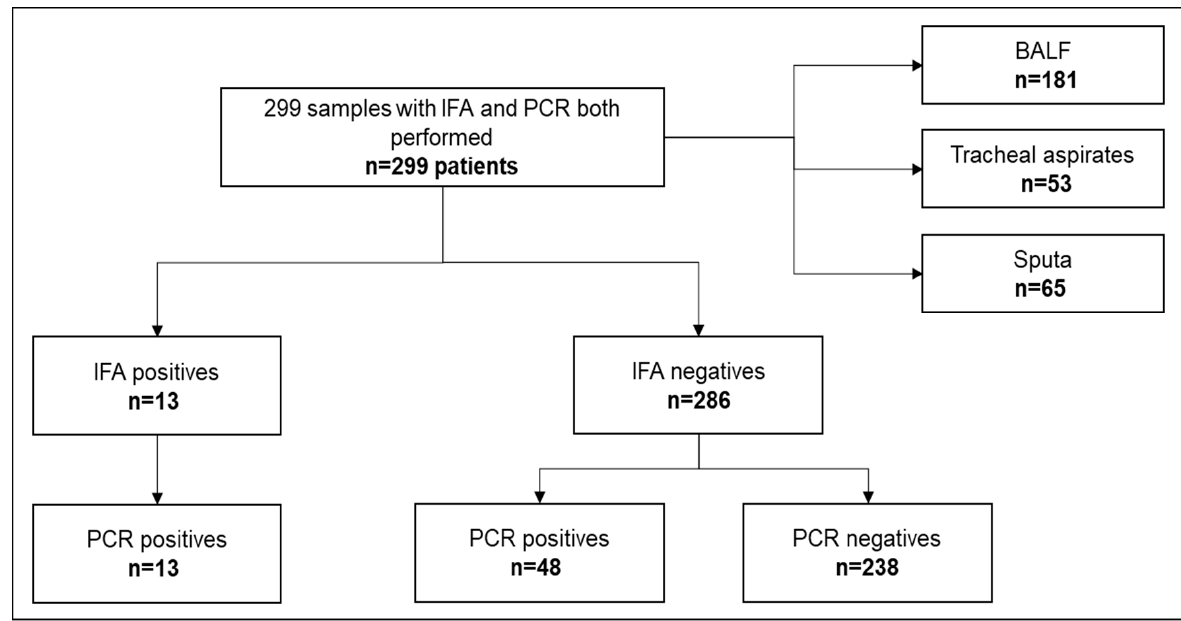
Figure 1. Flowchart of respiratory samples analyzed during the study period.